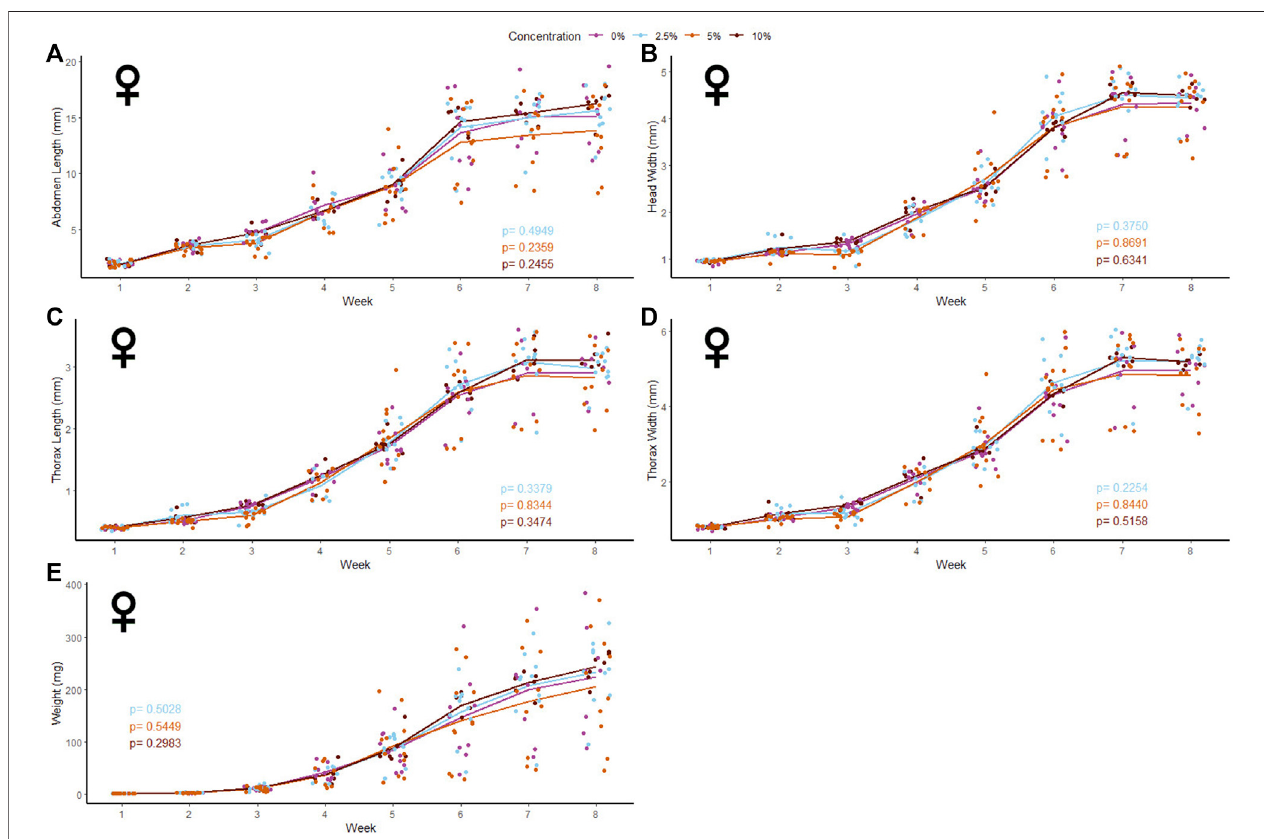
FIGURE 3 | Body size and mass of female Gryllodes sigillatus fed a diet containing PE microbeads. Initial measurements of crickets were taken once cricket nymphs emerged from eggs at week 1. Points represent individual cricket measurements and lines represent mean values between measurements. p -values are presented as an interaction of the concentration of PE microbeads with the week of growth. Each panel displays a different measure of body siz with (A) = abdomen length, (B) = head width, (C) = thorax length, (D) = thorax width, (E) = weight.